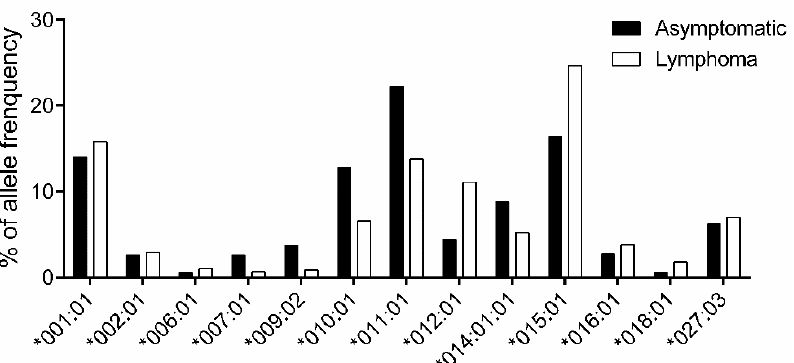
Figure 2. Comparison of BoLA-DRB3 allele frequencies between asymptomatic and lymphoma cows. Allele frequency in 250 asymptomatic ( ■ ) and 221 lymphoma ( □ ) cows were calculated for each BoLA-DRB3 allele (Table S3); 13 out of 32 alleles with frequency > 1% are shown. The X-axis shows the allele name and the Y-axis shows allele frequency (%) for each BoLA-DRB3 allele. Table 2. Fisher’s exact test based association analysis of BoLA-DRB3 alleles in asymptomatic and lymphoma cows.